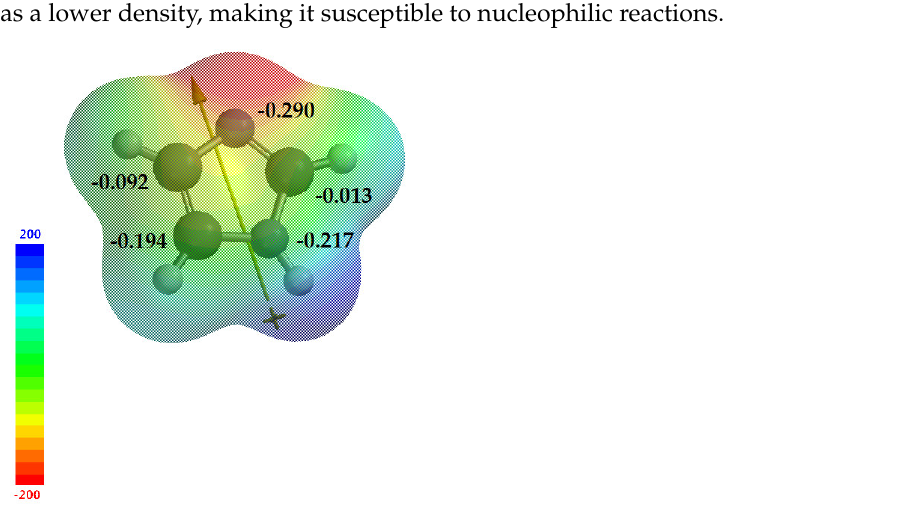
Figure 8. Electrostatic map of imidazole 1 , showing the natural charges of each atom and the dipole moment.